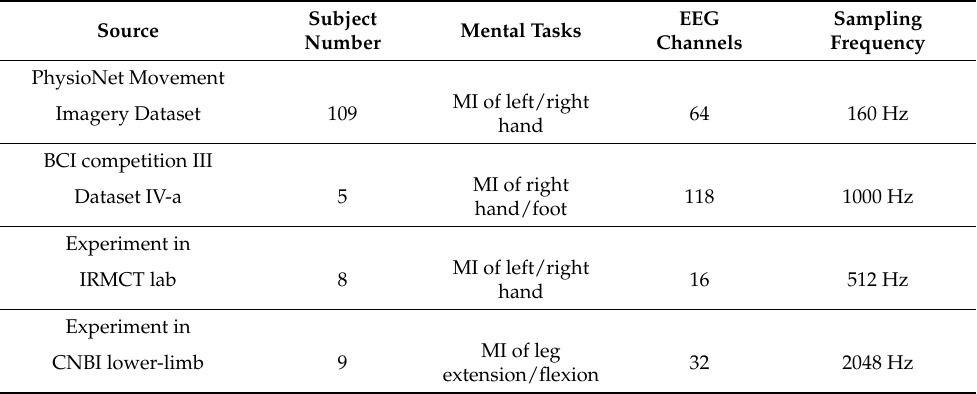
Figure 1. Snapshot of the two experimental scenarios with MI of the left hand vs. the right hand and MI of leg extension vs. flexion, which generate the third and the fourth dataset, respectively. Table 1. Data sources used in this